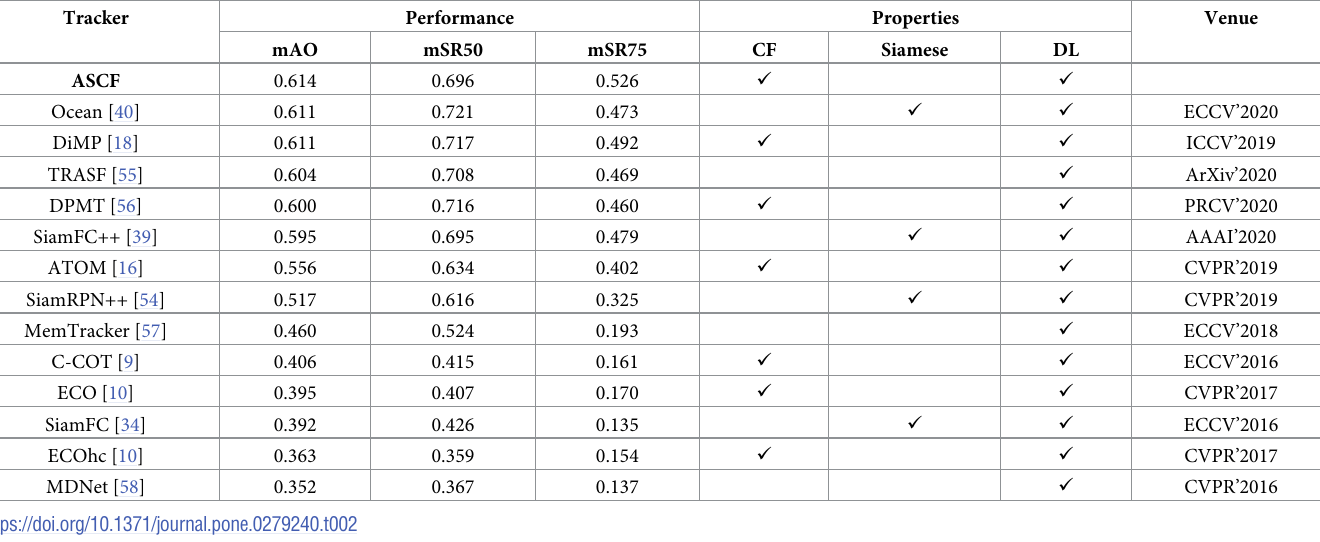
Table 2. Experimental results on GOT10K dataset.